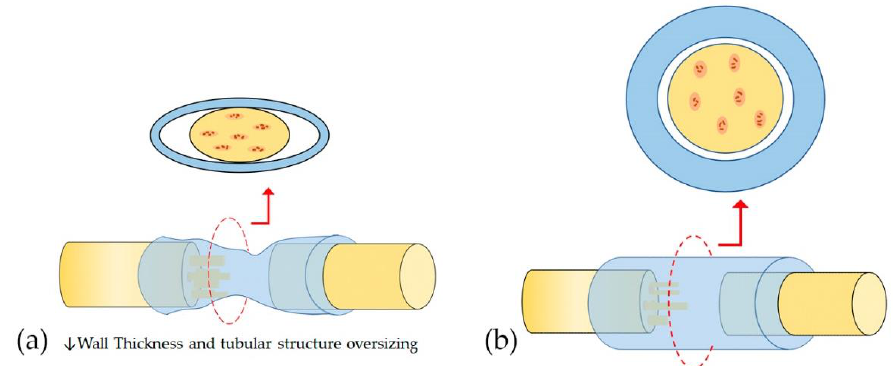
Figure 4. The behavior of the wall thickness and scaffold adjustment in the collapse of the NGC. ( a ) Shows imperfect filling and typical collapse of the NGC produced by low ( ↓ ) wall thickhness and tubular structure oversizing and with low wall thickness; ( b ) shows the behavior of an NGC adjusted to the peripheral nerve with an adequate wall thickness, achieving maintaining its tubular construct and exhibiting complete filling of the lumen.